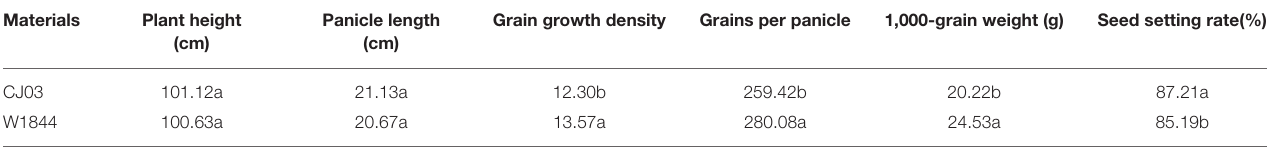
TABLE 1 | Agronomic traits of CJ03 and W1844.